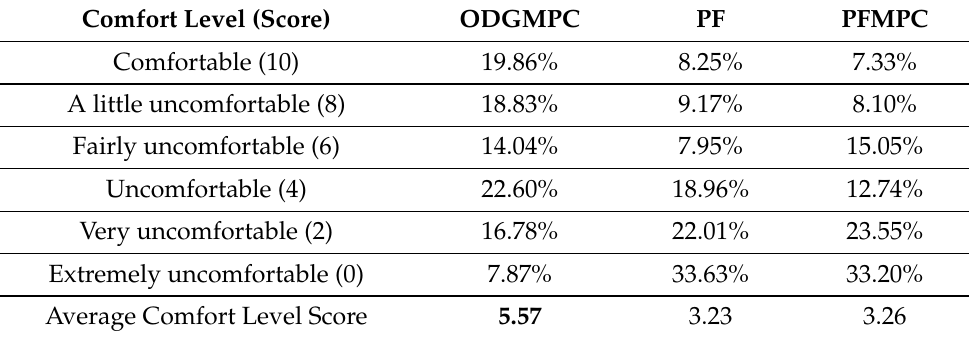
Figure 24. Results of the obstacle distance from Scenario 2 for a dynamic obstacle. Table 8. Average result scores for 10 experiments in Scenario 2 for a dynamic